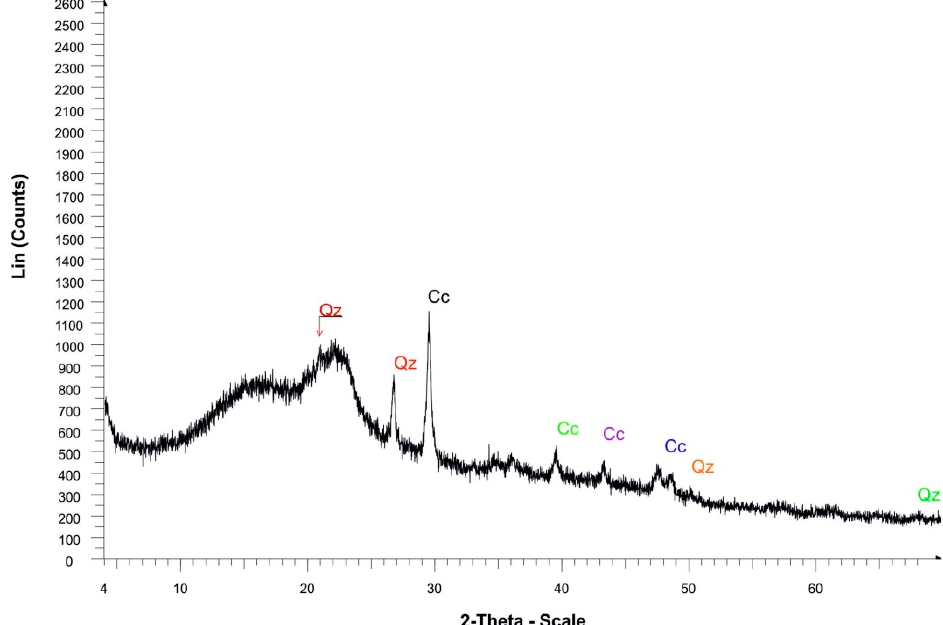
Figure 7. XRD pa tt erns of the Egagropili samples from Kefalonia Island. Figure 7. XRD patterns of the Egagropili samples from Kefalonia